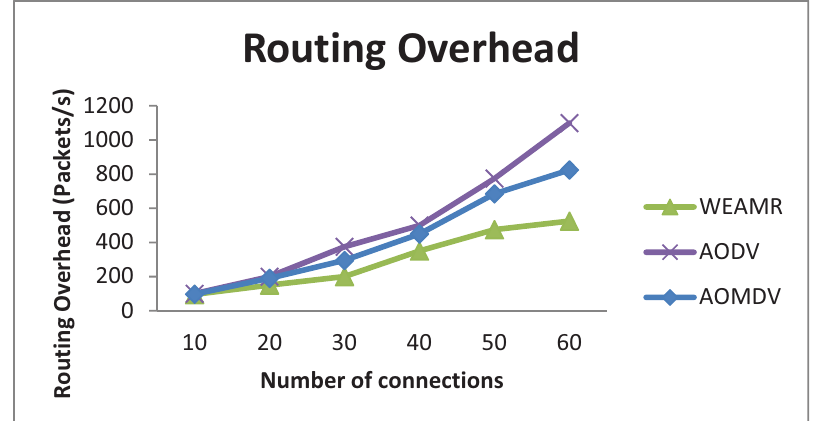
Figure 13. Average Routing overhead with increasing number of